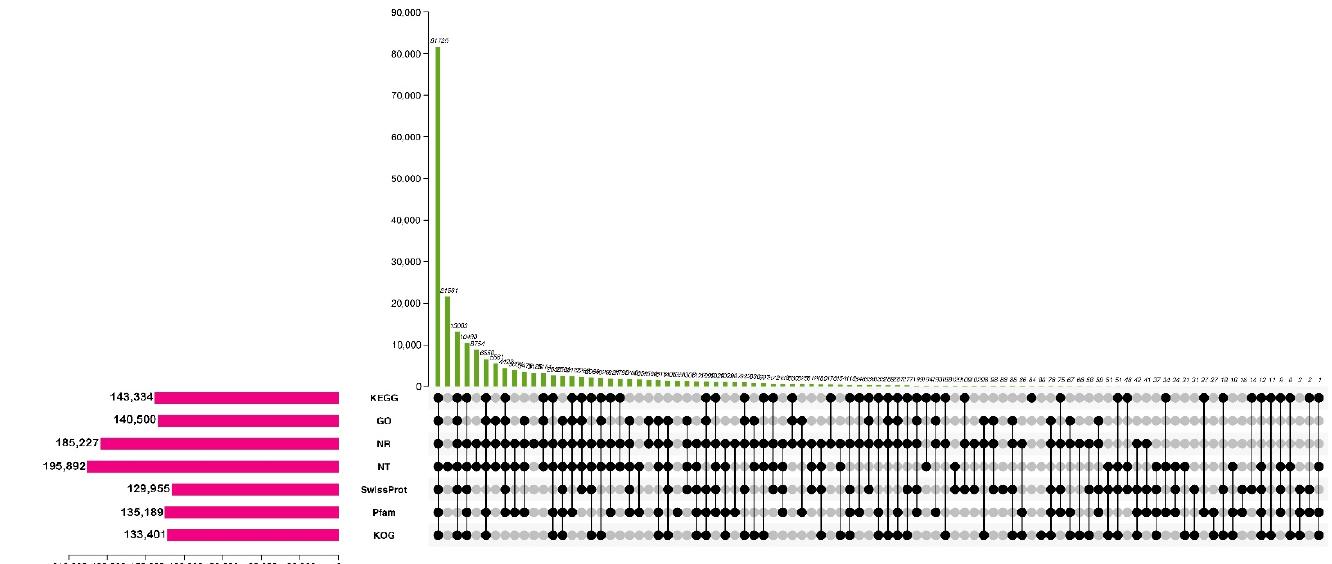
Figure 1. BLAST hits for unigenes against seven public databases. Plants 2022 , 11 , x FOR PEER REVIEW